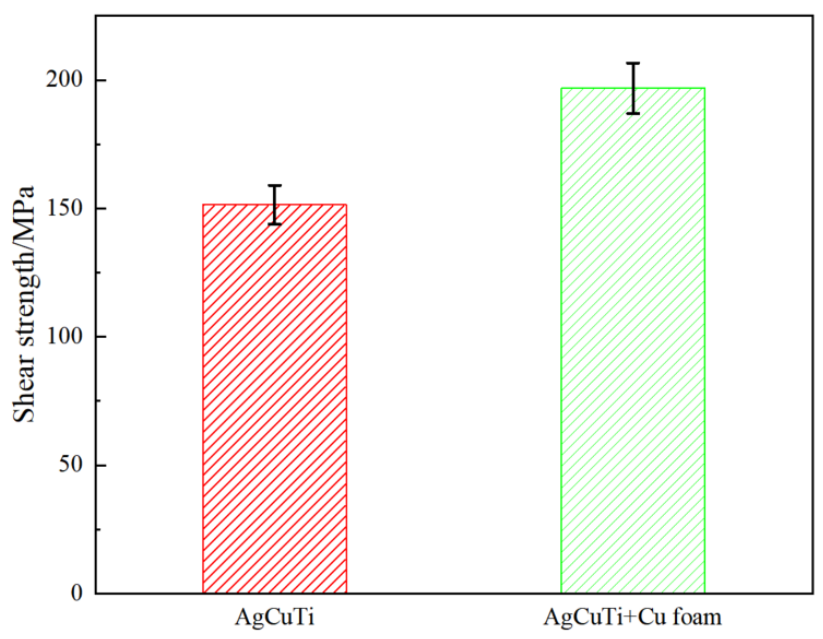
Figure 11. Shear strength of brazed joints with and without Cu